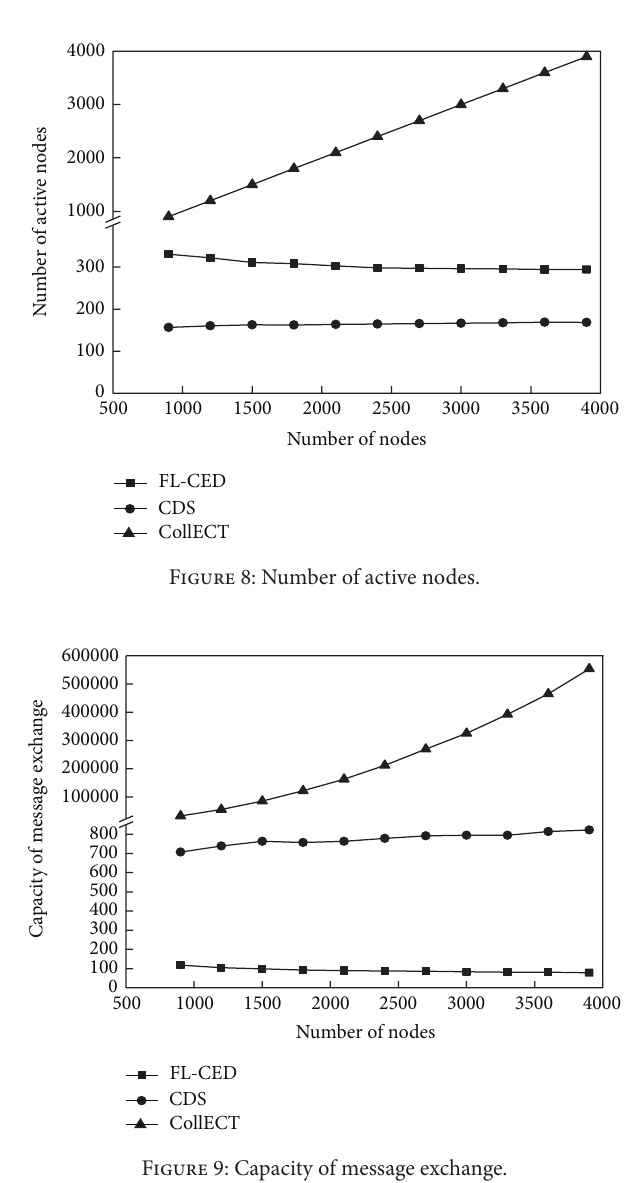
Figure 9: Capacity of message exchange.